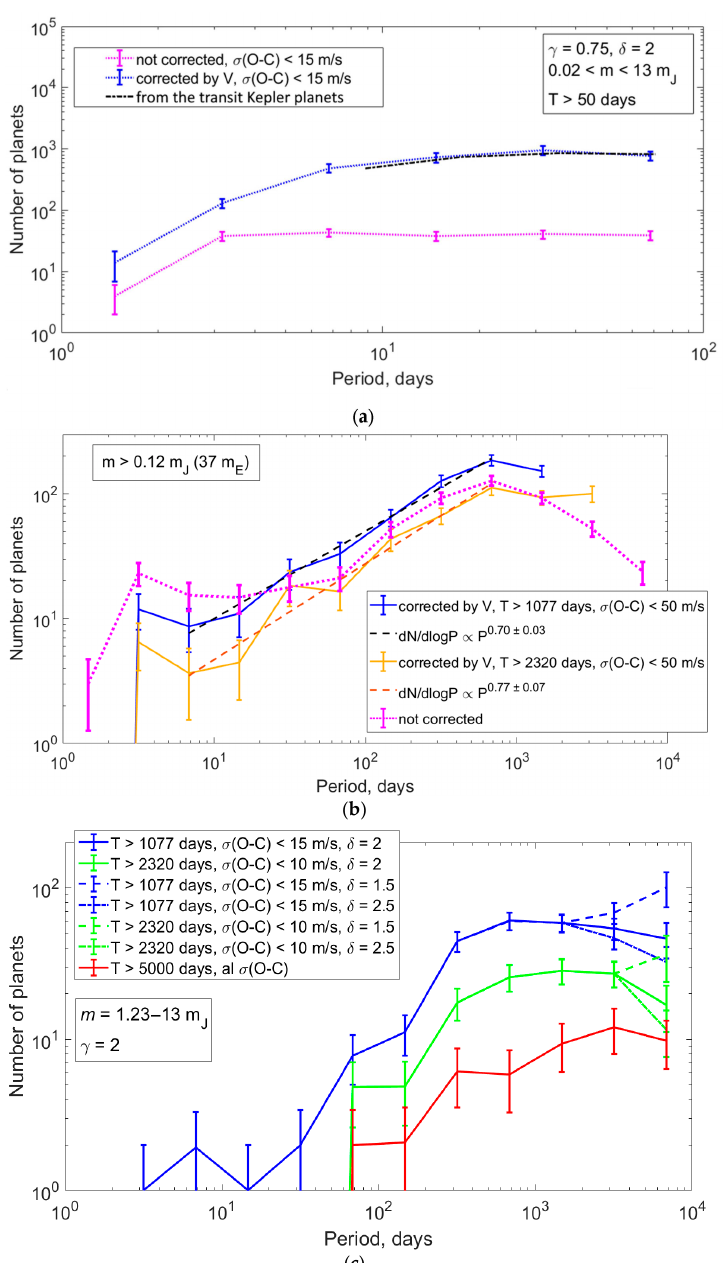
Figure 8. The orbital-period distribution of RV planets. ( a ): N A ( P ) (14a)—de-biased distribution of planets with masses m = (0.02 − 13)M J and orbital periods P = 1 − 100 days for γ = 0.75; the dotted blue line shows the distribution of planets with σ (O − C) < 15 m/s. The orbital-period distribution of the transit Kepler planets with radii of (1 − 16)R E and orbital periods of 6.25 − 100 days is shown by black dash-dot line [17]. ( b ): De-biased N B ( P ) (14b)—distributions of planets with masses m = (0.12 − 13)M J for γ = 1.6: blue line— σ (O − C) < 50 m/s, the orange line— σ (O − C) < 50 m/s, T > 2320 days. The dashed lines in black and brown show approximations by power lows with exponents 0.70 and 0.77, respectively (d N /dlog P ∝ P 0.70 ± 0.03 and d N /dlog P ∝ P 0.77 ± 0.07 ). Initial from NASA Exoplanet Archive [1] (biased) distribution is shown by dotted magenta line. ( c ): The de-biased distributions of planets with m = (1.2 − 13)M J , P = 1 − 10 4 days for γ = 2 and δ = 1.5, 2.0, and 2.5. Red line— T > 5000 days, green lines − T > 2320 days and σ (O − C) < 10 m/s, blue lines— T > 1077 days and σ (O − C) < 15 m/s. Solid lines show the distributions corrected by δ = 2.0, dash lines—by δ = 1.5, dotted lines − by δ = 2.5.